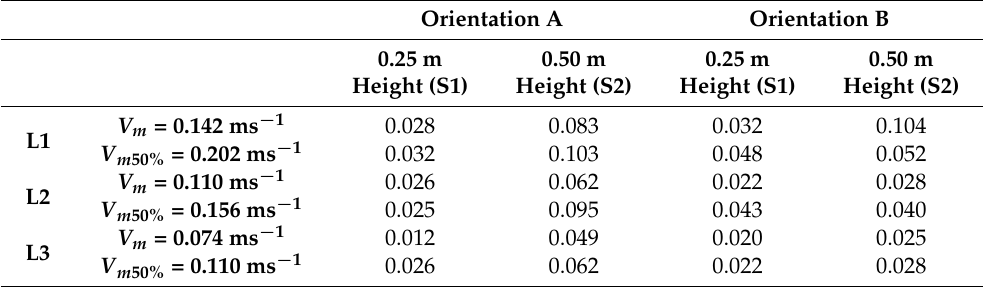
Table 4. Experimental